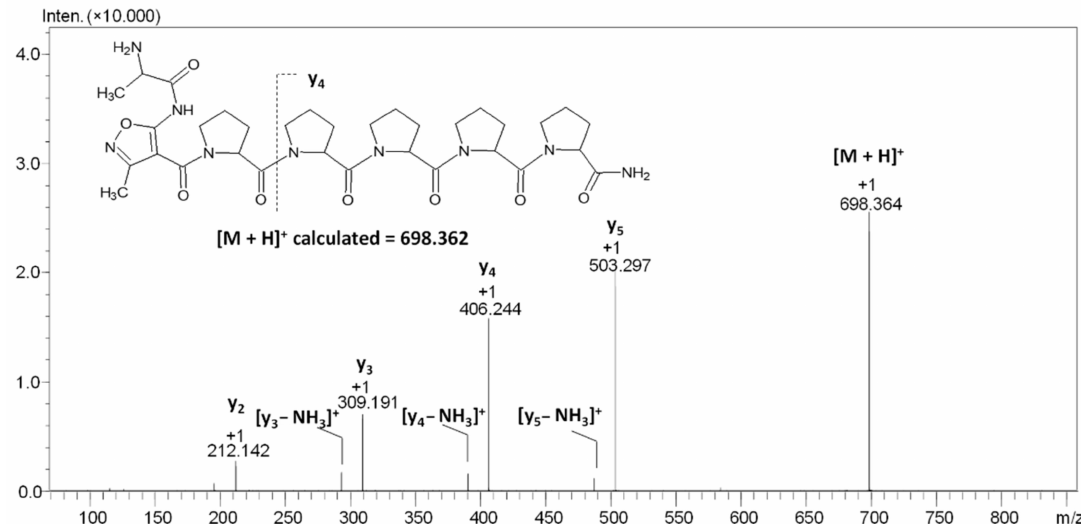
Figure 8. ESI-MS/MS spectrum of compound 4 . Parent ion m / z 698.364, collision energy 20–40